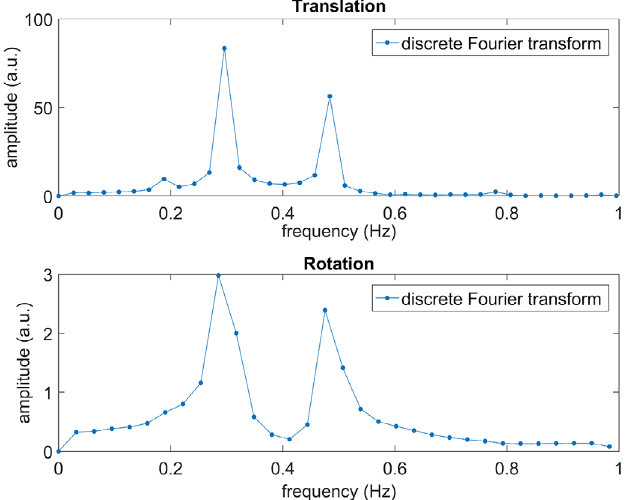
Fig. 7. Spectral analysis of the Wilberforce effect, performed with MATLAB FFT.